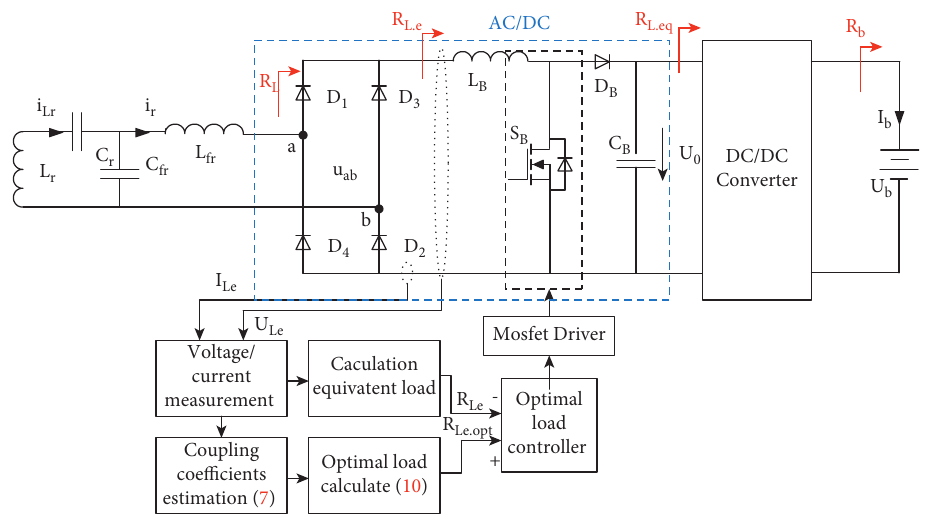
Figure 7: Closed-loop control block